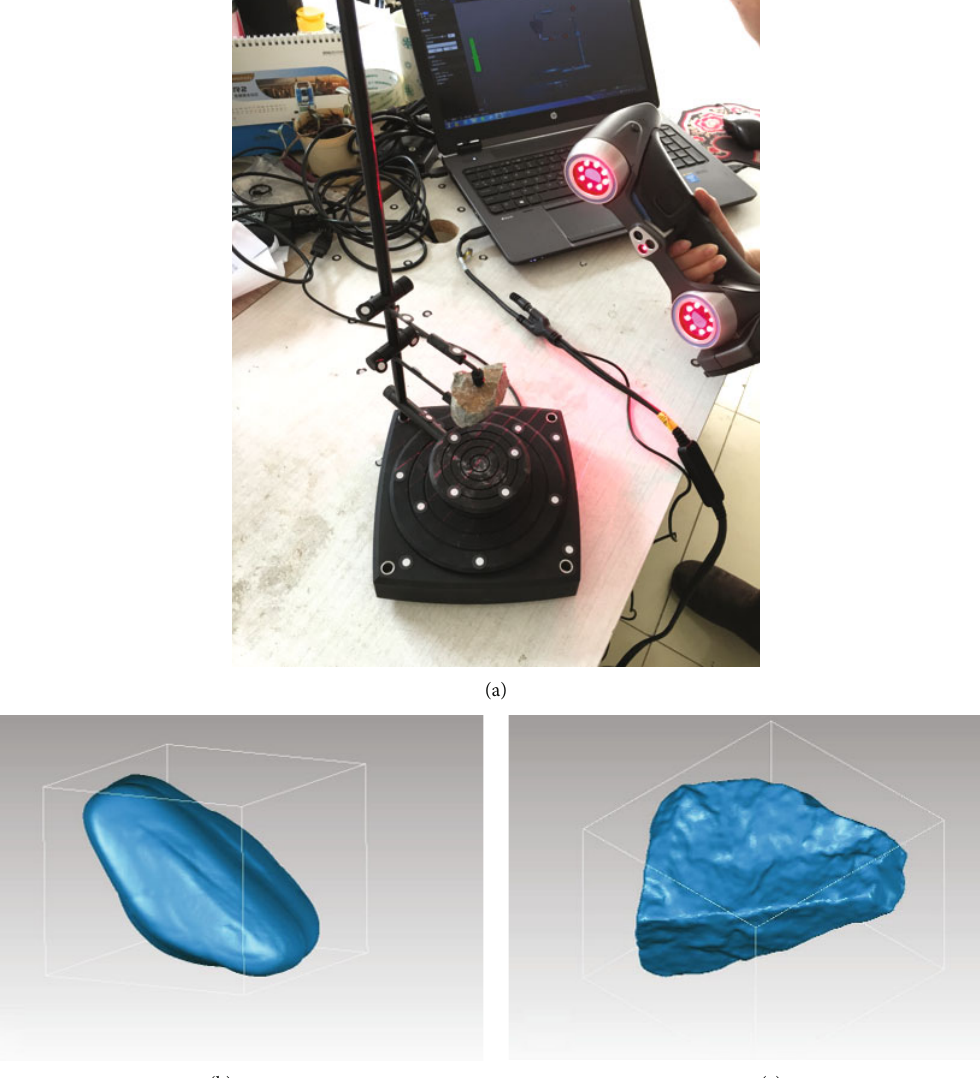
Figure 3: Schematic diagram of a three-dimensional laser scanner and typical gravel particles: (a) laser scanner; (b) oval particles; (c) cubic particles.